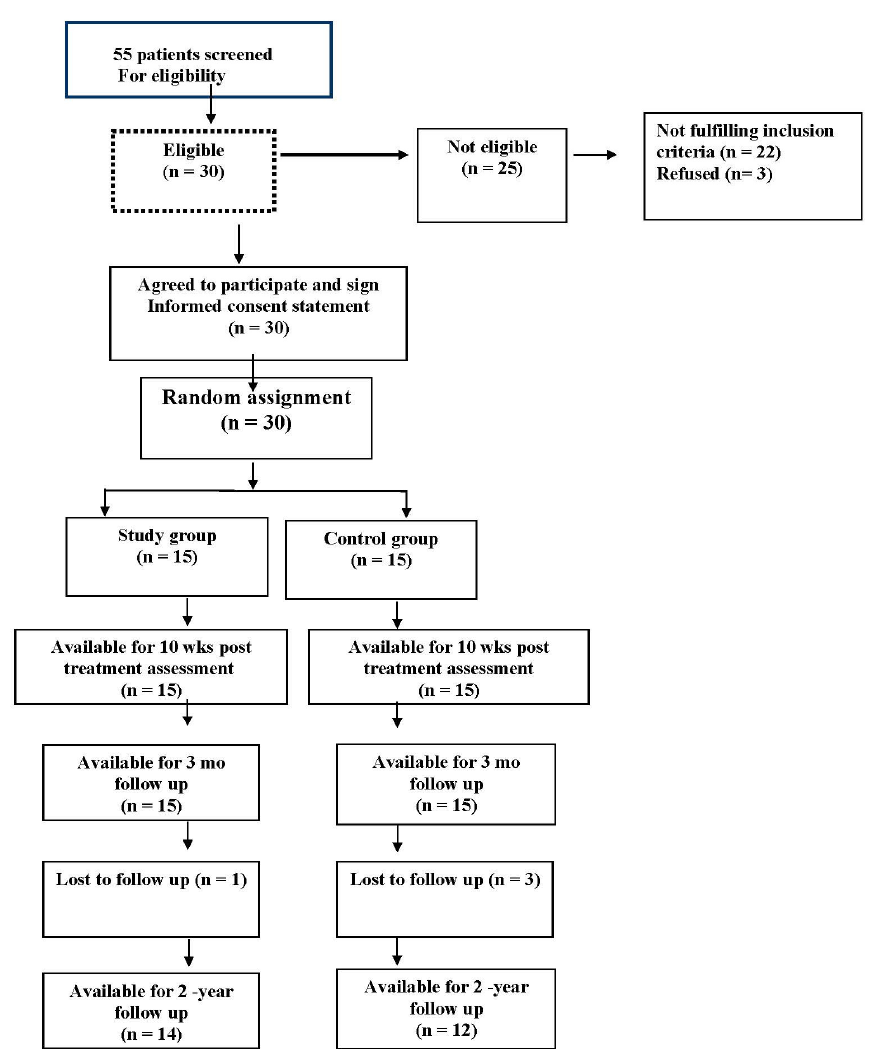
Figure 4. A diagram of patients’ retention and randomization throughout the study is shown.